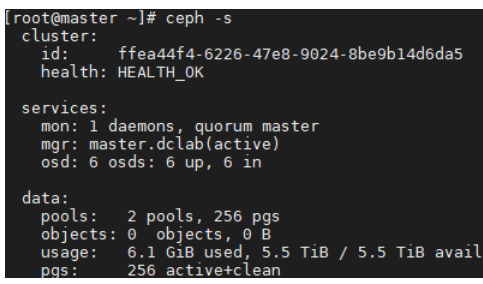
Figure 6. Ceph cluster